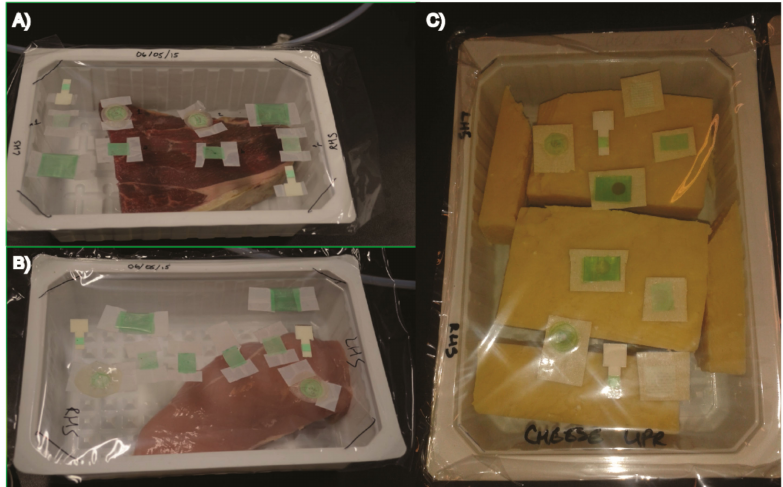
Figure 1. Photographs of O 2 sensors inserted in sealed MAP: beef steak ( A ); chicken breast ( B ); and cheese ( C ) packages (shown in upright